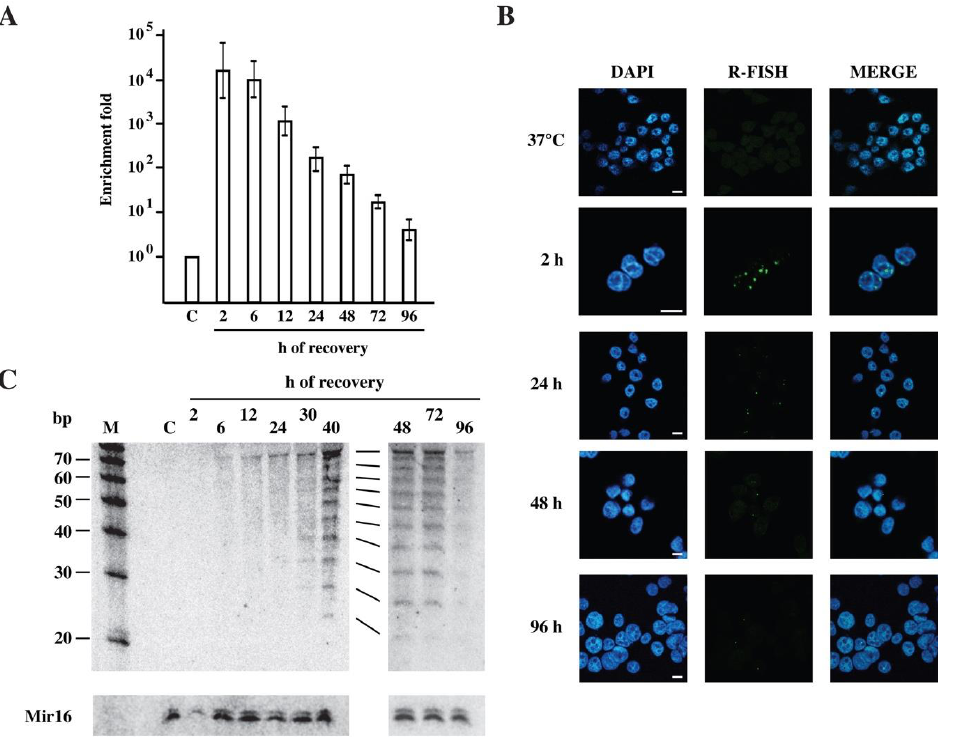
Figure 1 . SatIII RNAs mark a long period of recovery from stress. ( A ) Total RNAs were extracted from unstressed HeLa cells ( C ) and from cells heat shocked for 1 h at 42 °C and then allowed to recover at 37 °C for the indicated time periods. The expression level of SatIII RNAs was determined using real time PCR, as described [25], and expressed as a function of the basal level observed in control cells. The histogram represents the average of three independent experiments ± standard deviation. ( B ) The same cell populations were analyzed using in situ RNA FISH with a biotinylated oligo against SatIII RNAs, as previously described [23]. Cell nuclei were stained using DAPI. ( C ) Short RNAs were prepared from HeLa cells treated as in panel A, separated on 5% polyacrylamide gels and analyzed using Northern blotting with a locked nucleic acid (LNA) oligo specific for SatIII repeats. M: molecular size markers. The same filter was hybridized to a probe specific for Mir16 as a loading control.Bars: